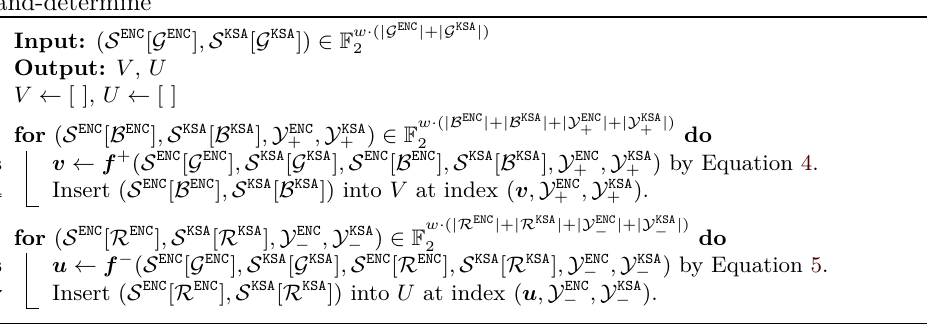
Algorithm 2: Computing the solution spaces of the neutral words with guess-